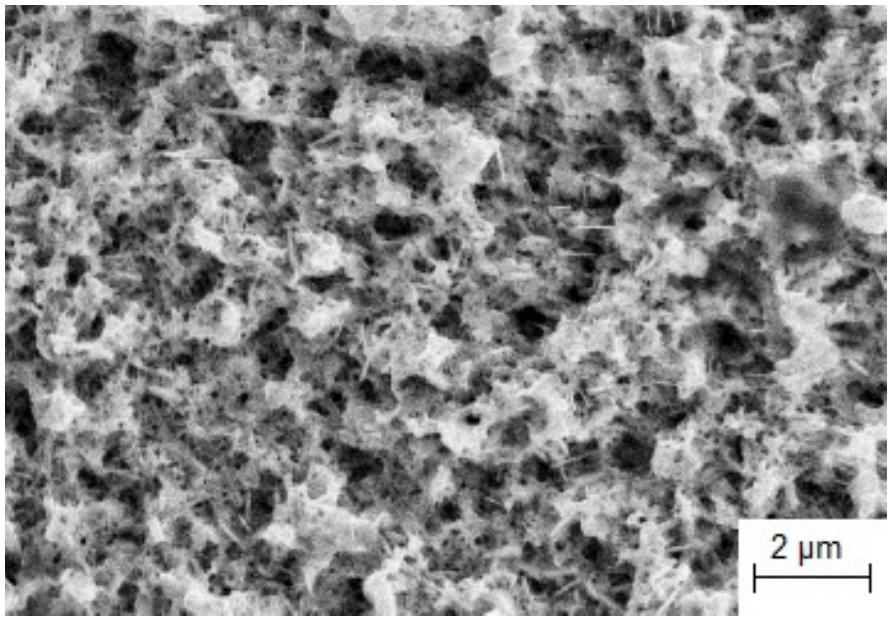
Figure 2. Morphology of molybdenum carbide coating on a molybdenum substrate. T = 1123 K, i = 5 mA cm − 2 , melt–NaCl-KCl-Li 2 CO 3 (1.5 wt.%)-Na 2 MoO 4 (8.0 wt.%).